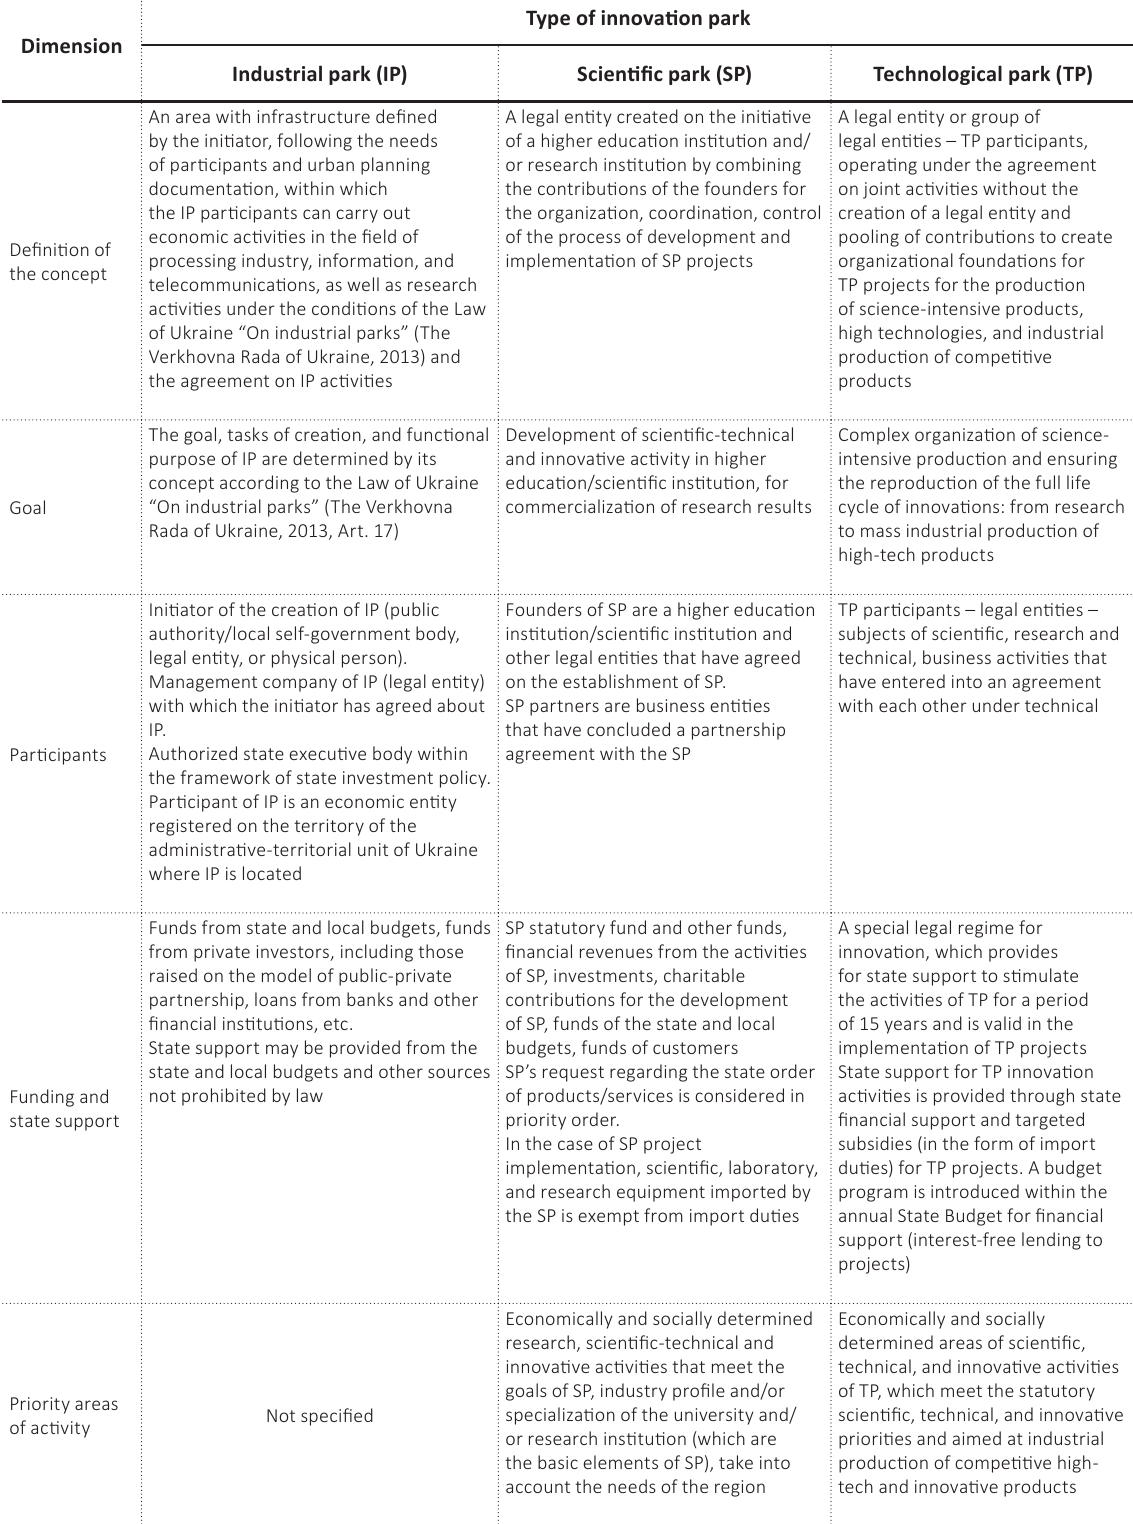
Table A2. Main aspects of IP included in the Register of industrial parks as of November 12, 2020, under the Ukrainian